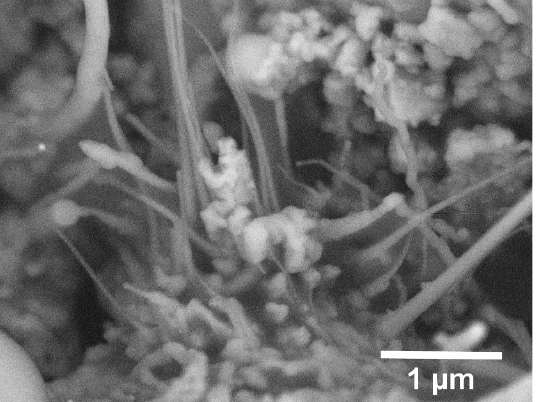
Figure 4. SEM image of 1200 °C treated samples showing the growth of SiC whiskers inside pores resulting from carbothermal reduction of the native oxide layers of starting particles by the free carbon remnants of the polymer derived SiC.